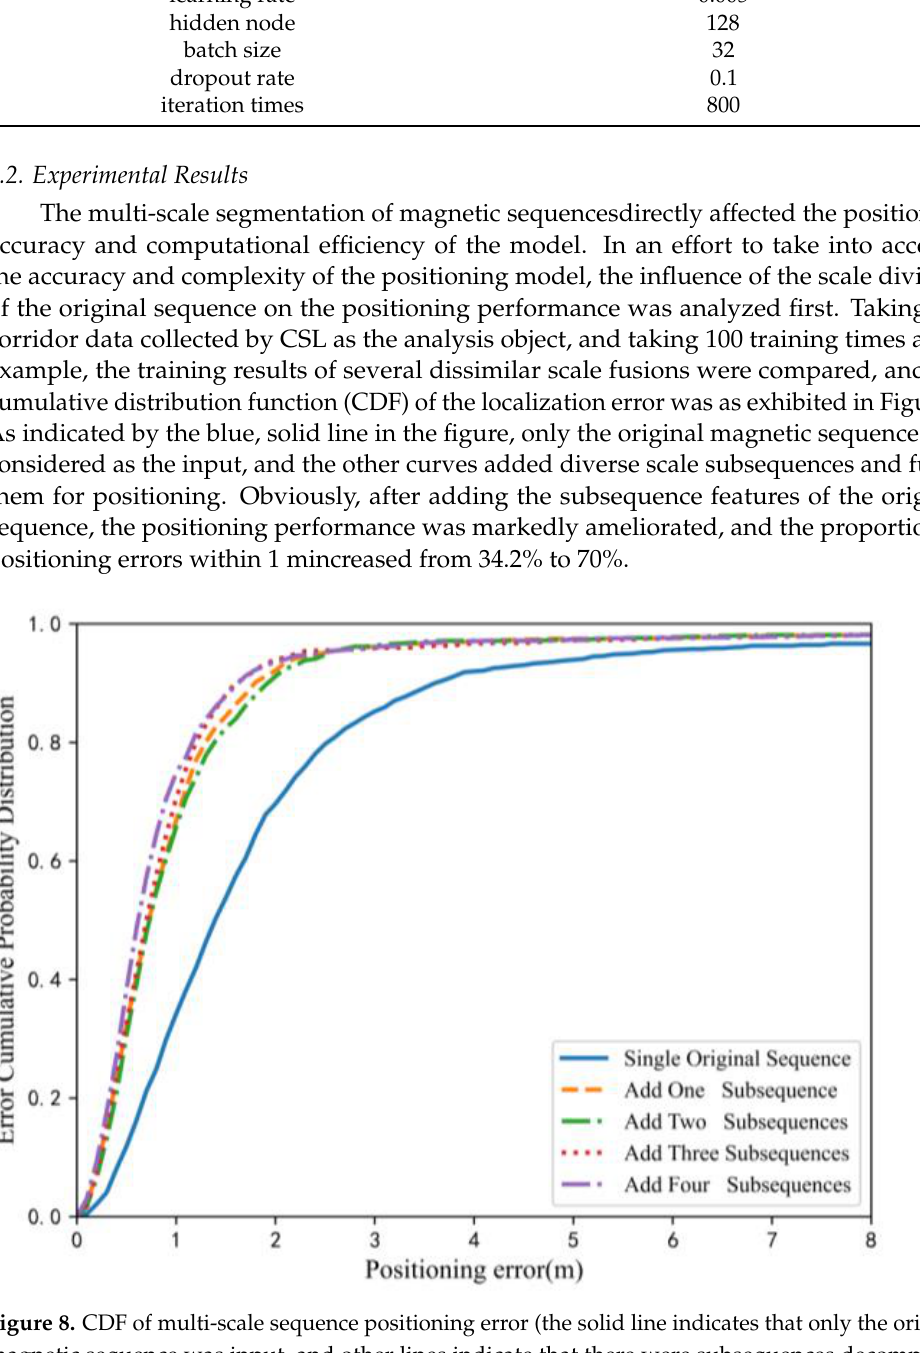
Figure 9. Box plot of multi-scale sequence fusion positioning error (zero represents the positioning result of a single original sequence as input, and other representations fuse the corresponding num- ber of diverse scale subsequences.). With regard to the three indoor scenes of the corridor, open area and complex area, the multi-scale fusion positioning of magnetic sequences was carried out respectively, and the cumulative distribution of the positioning error of the three scenes was as displayed in Figure 10. The average positioning errors of multi-scale fusion positioning in the three regions was 0.65 m, 0.93 m and 1.38 m, respectively, with excellent positioning accuracy. In the public data set, 94% of the samples of the corridor data had a positioning error less than 1 m, and 90.4% had a positioning error of less than 0.6 m. Furthermore, the test results in the open area were close to the data in the corridor, and the error of 91.5% of the test results was controlled within 1 m. Of the positioning results of the test sample of the com- plex area, 81.8% had an error within 1 m. In comparison with the previous two areas, the positioning performance was slightly decreased, which correlated with the acquisition density of the original data in the complex area. The bookshelf and various office furniture made the data acquisition unable to traverse each point on the positioning plane.